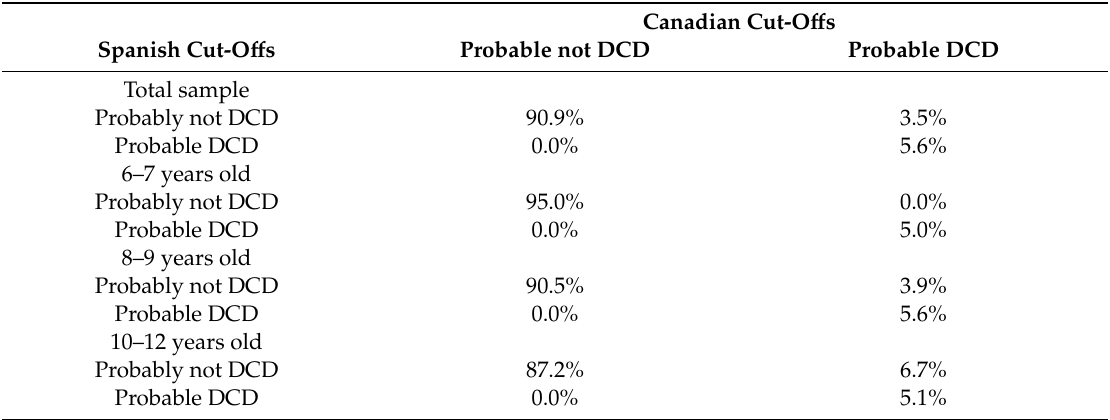
Table 5. Prevalence of children diagnosed with probable DCD using Canadian or Spanish cut-o ff points ( n =